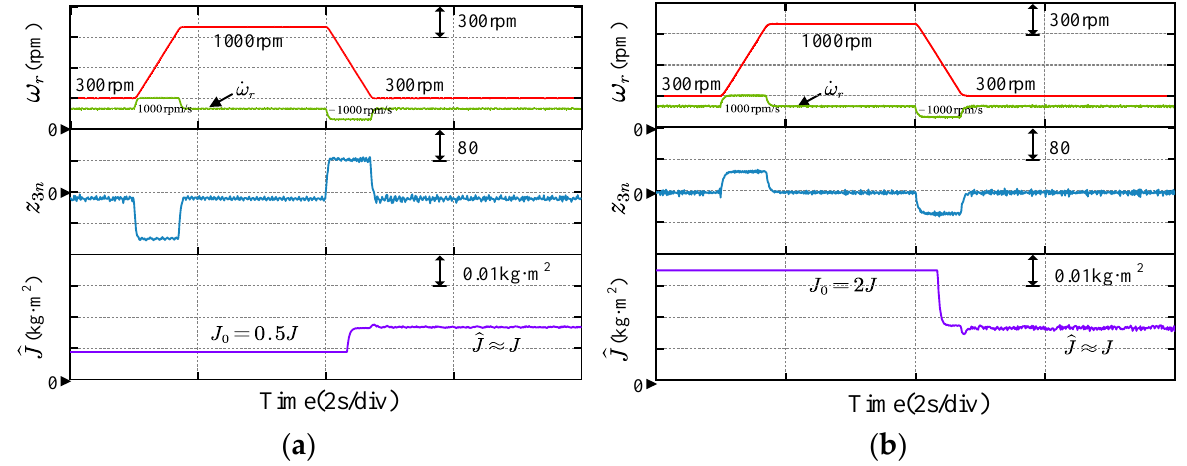
During this experiment, the IPMSM makes a speed transition from 300 rpm to 1000 rpm, and then back to 300 rpm. The controller parameters are set to ω 0 n = 120 π , k n = 10 π . Figure 19a,b shows the experimental results with initial inertia respectively set to 0.5 J and 2 J . It can be seen that the identified inertia converges quickly within 0.3 s, and the identified value is close to the actual value, which is 0.0174 kg · m 2 .